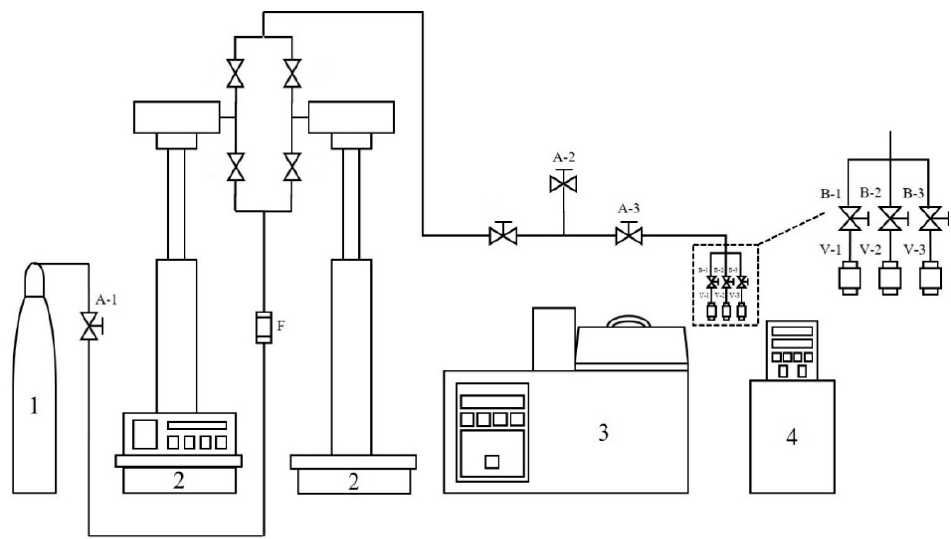
Figure 1. Experimental apparatus of supercritical CO 2 foaming (1: CO 2 cylinder, 2: syringe pump system, 3: thermostatic oil bath, 4: circulating chiller, V: high-pressure vessel, F: filter, A: two-way needle valve, B: three-way ball valve).